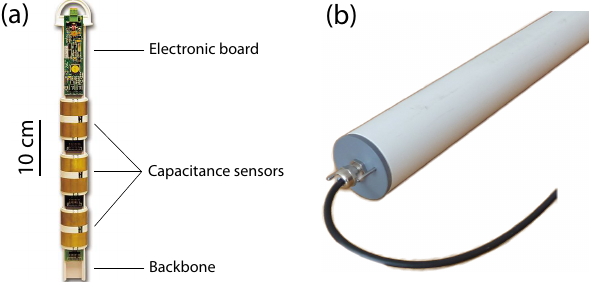
Fig. 7. (a) Capacitance probe EnviroSmart. The position of the elec- tronic board and of sensors can be freely adjusted on the backbone; the setups used in our field deployments are described in Sect. 6. (b) Modified access